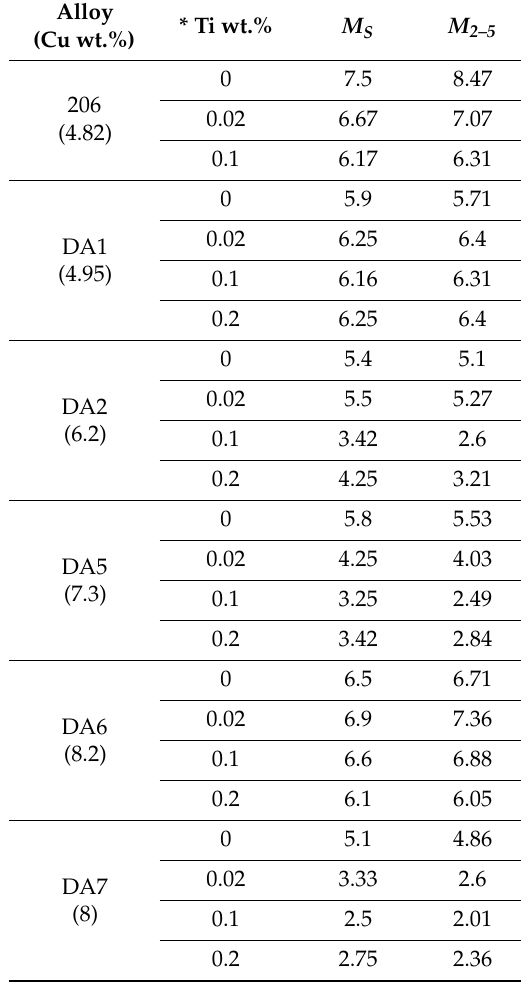
Table 4. Hot-tearing indices M S and M 2–5 from multi-arm